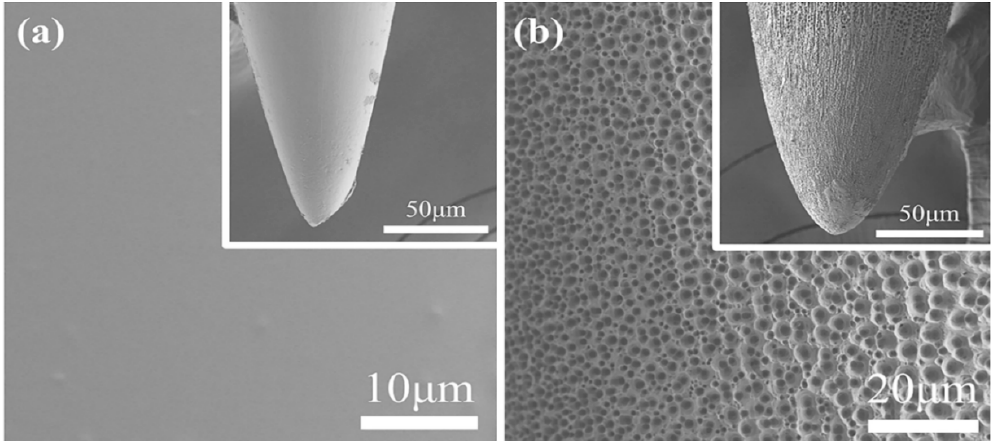
Figure 3. Surface Field Emission Scanning Electron Microscope (FE-SEM) images of ( a ) CNE and ( b ) PNE.